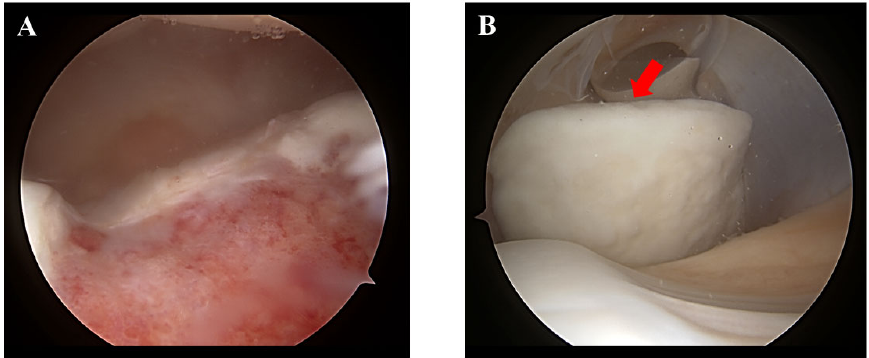
Figure 3. Arthroscopic viewing via the anterolateral portal ( A ) and anteromedial portal ( B ). The osteochondral fragment was completely detached from the intercondylar groove ( red arrow ).